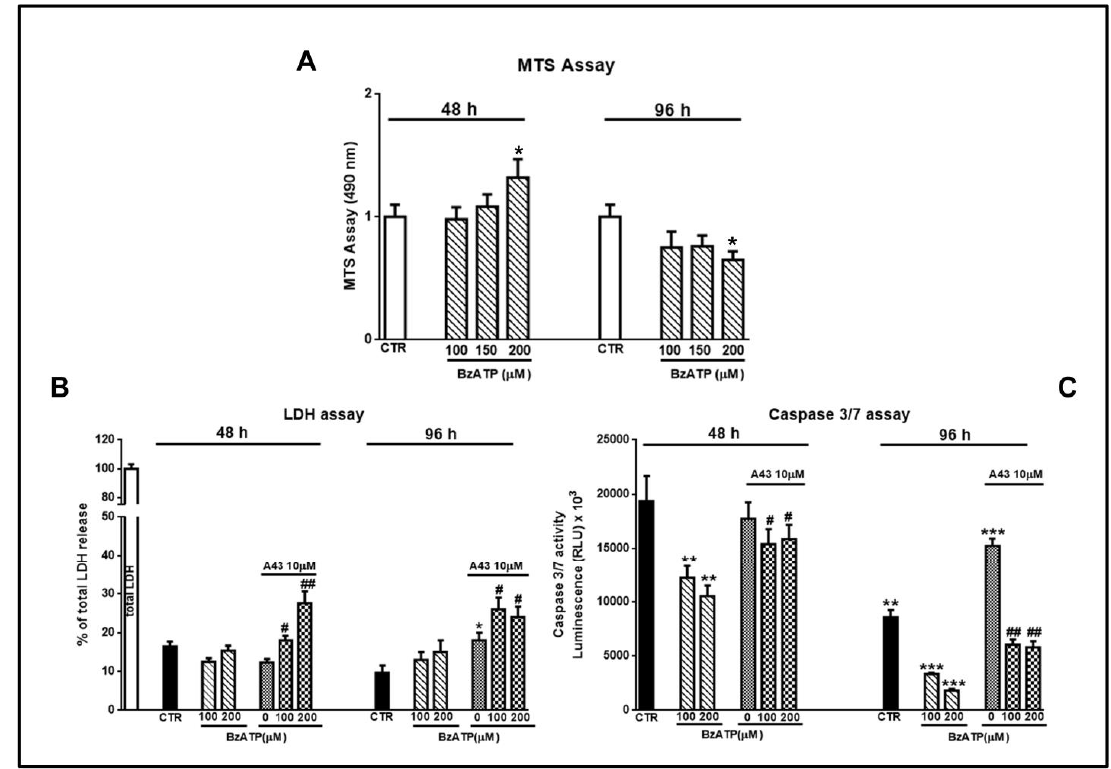
Figure 10. Evaluation of cell viability and of necrotic or apoptotic death induced by GSC exposure to BzATP. GSCs were treated with BzATP and in some experiments they were pretreated with the P2X7 receptor (P2X7R) antagonist A438079, administered 1 h prior to the agonist. After di ff erent